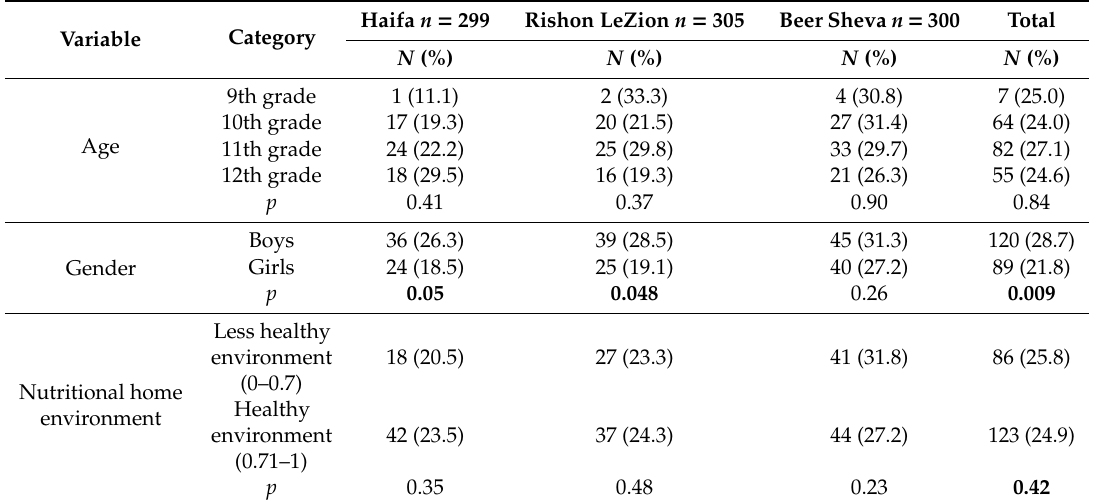
Table 2. Percent of obese and overweight adolescents according to city, age, gender and nutritional home environment (Chi-square).